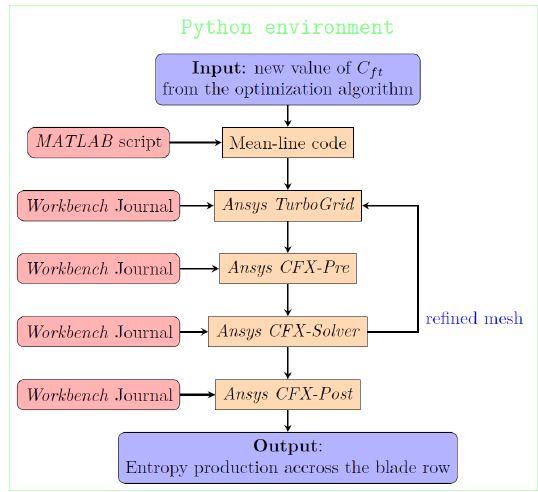
Figure 10. Flowchart to illustrate the procedure used to calculate the entropy production for each value of C ft given by the optimization algorithm.